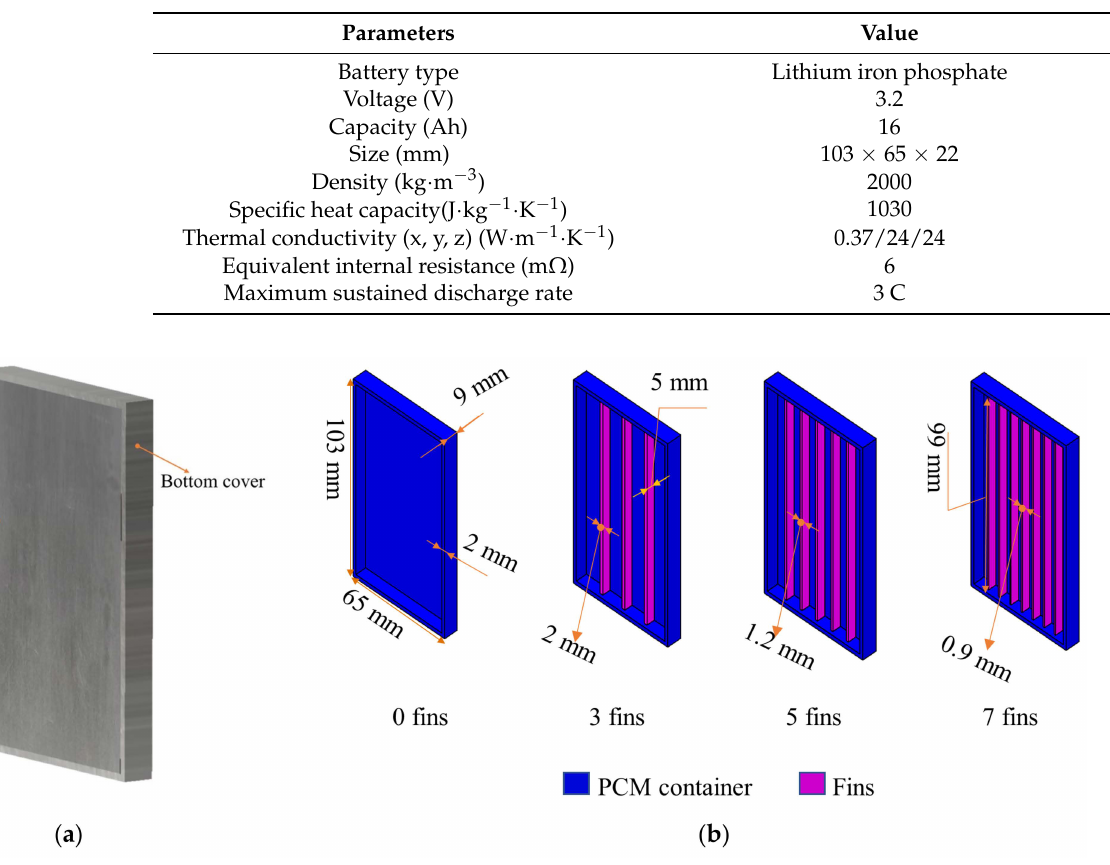
Table 1. Parameters of Li-ion battery.